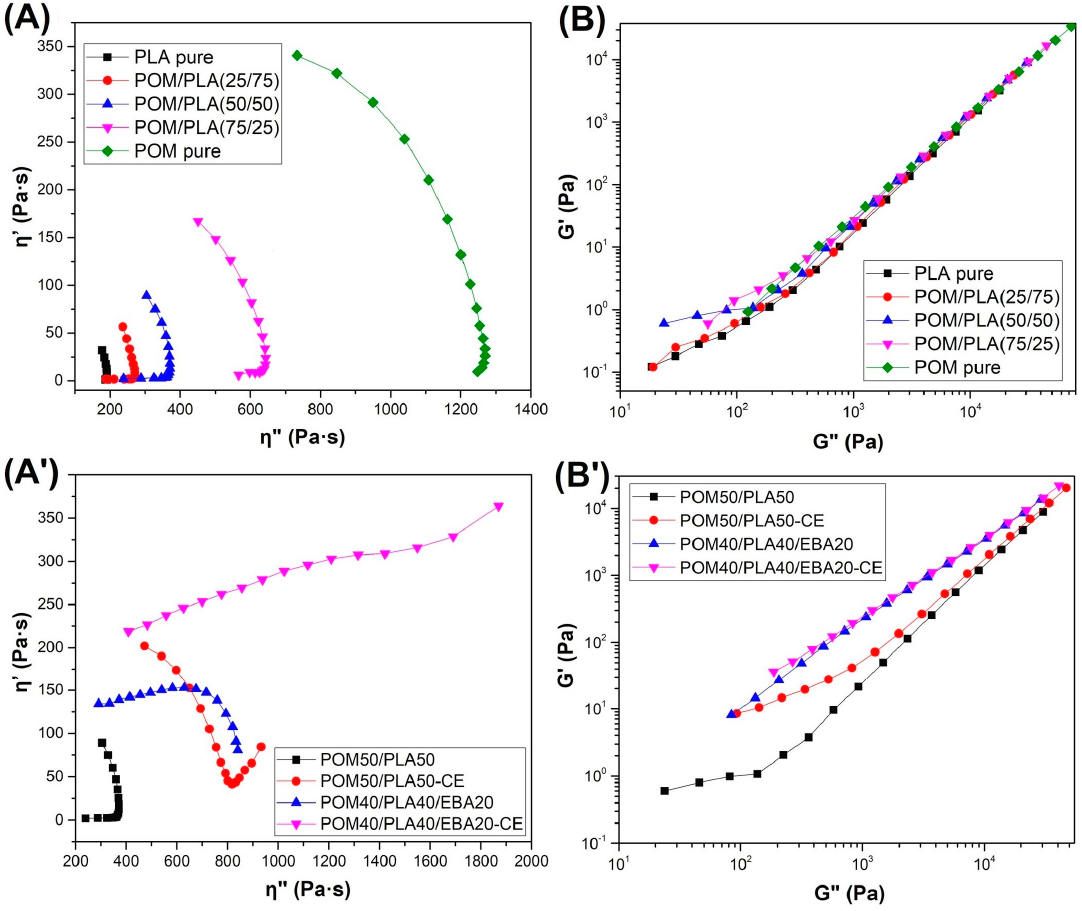
Figure 6. Cole–Cole plots ( A , A’ ) and Han plots ( B , B’ ) for unmodified POM/PLA blends and EBA/CE- EBA / CE-modified POM50 / PLA50 modified POM50/PLA50 blends.